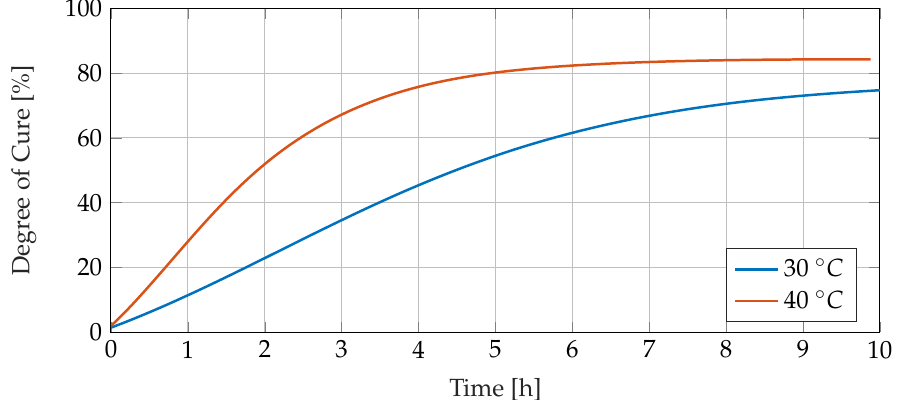
Figure 8. Degree of cure for RIMR426 with curing agent RIMH435 during isothermal cure at 30 and 40 ◦ C calculated from DSC data.